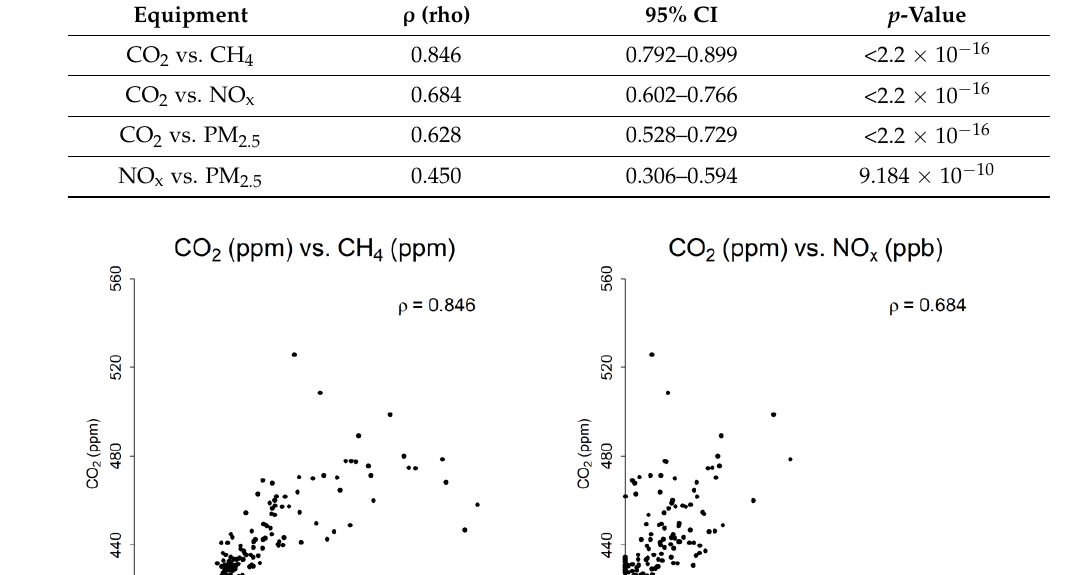
Table 7. Bonneville Phase 2 Spearman correlation test results for van pollutant readings.